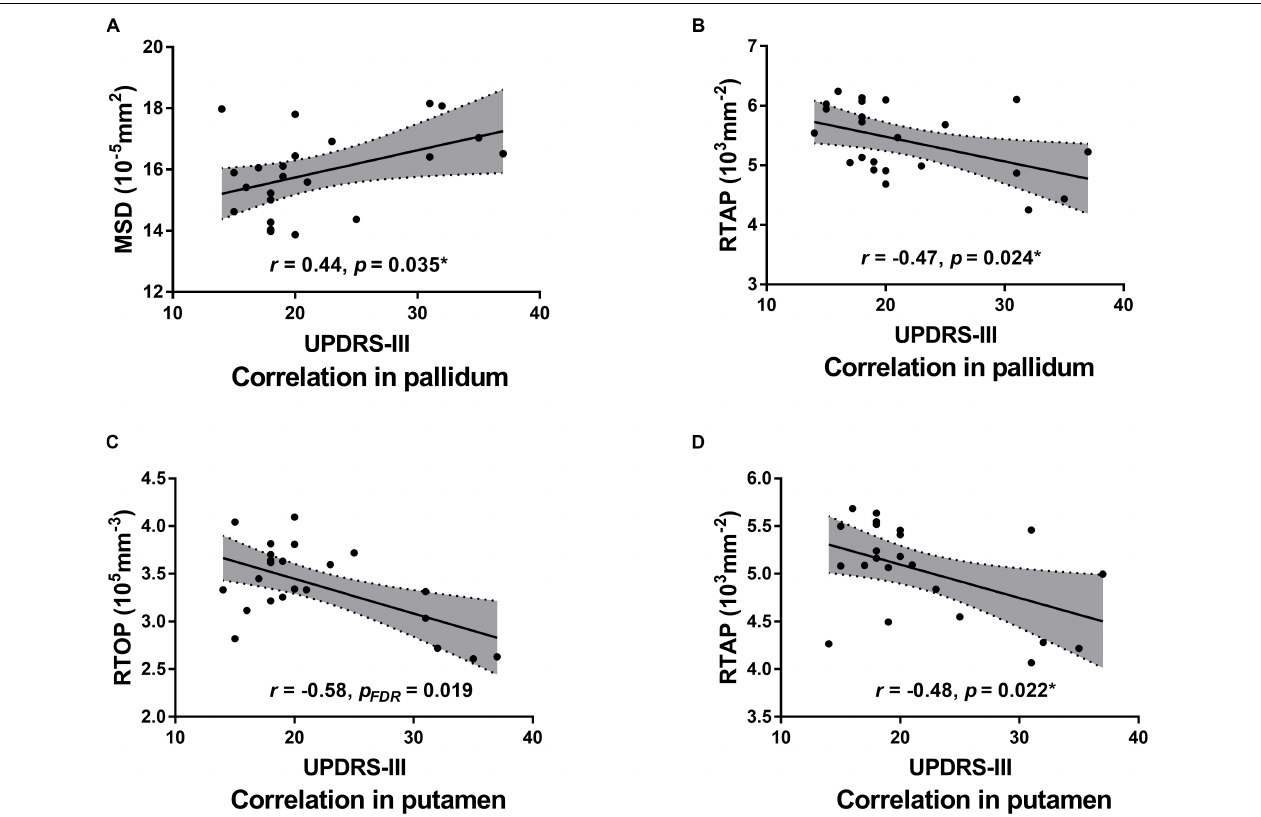
FIGURE 6 | Scatter plots of the significant correlations between MAP MRI measurements and UPDRS-III motor scores (“on” medication state) in the bilateral pallidum (A,B) and putamen (C,D) . Pearson correlation coefficients and associated p -values are shown. The shaded areas represent the 95% confidence interval for each regression line.